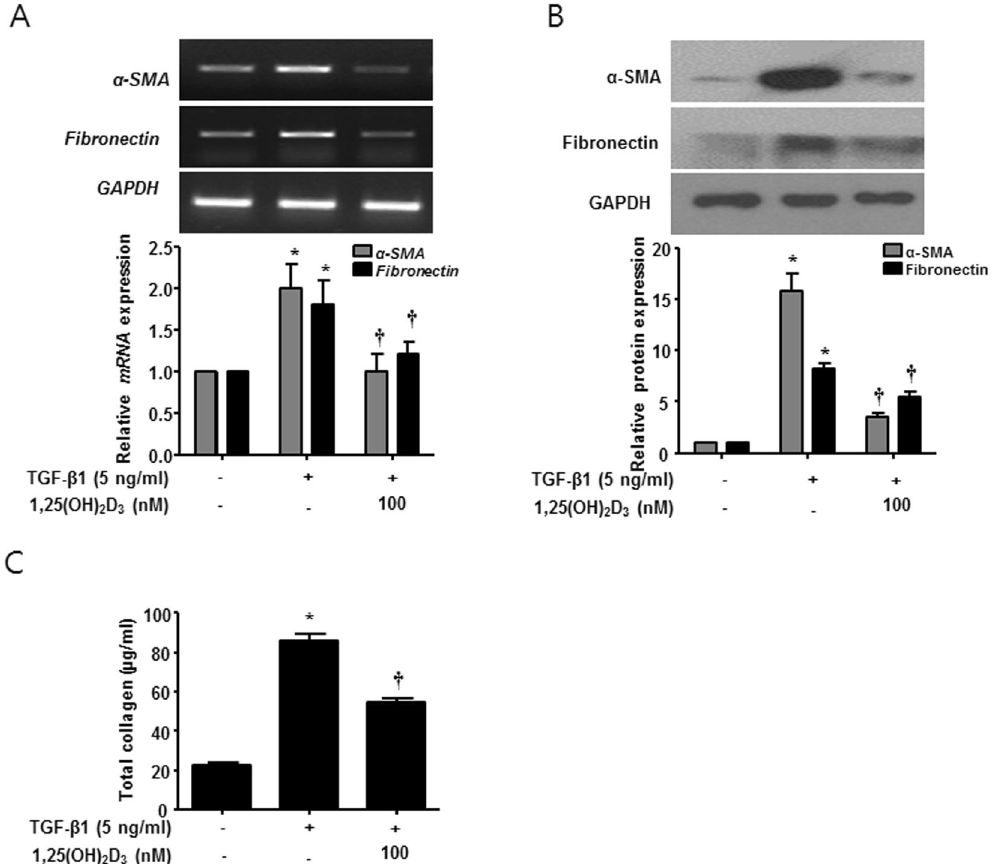
Figure 6. 1,25(OH) 2 D 3 decreases TGF- β 1-induced collagen production in ex vivo organ culture of nasal polyps. Nasal polyps were stimulated with TGF- β 1 and/or 1,25(OH) 2 D 3 for 72 hours. ( A , B ) Expression levels of α -SMA and fibronectin mRNA and protein were determined by semi-quantitative RT-PCR analysis and Western blot analysis. Expression of housekeeping GAPDH was utilized as an internal control. A representative experiment and quantitative determination of α -SMA mRNA and protein levels are shown. ( C ) The amount of total soluble collagen in culture media was quantified using the Sircol assay. All data are presented as mean ± SEM. Four nasal polyp specimens from different donors were used. All experiments were performed in at least triplicate and repeated at least three times. * p < 0.05 vs. control, † p < 0.01 vs. TGF- β